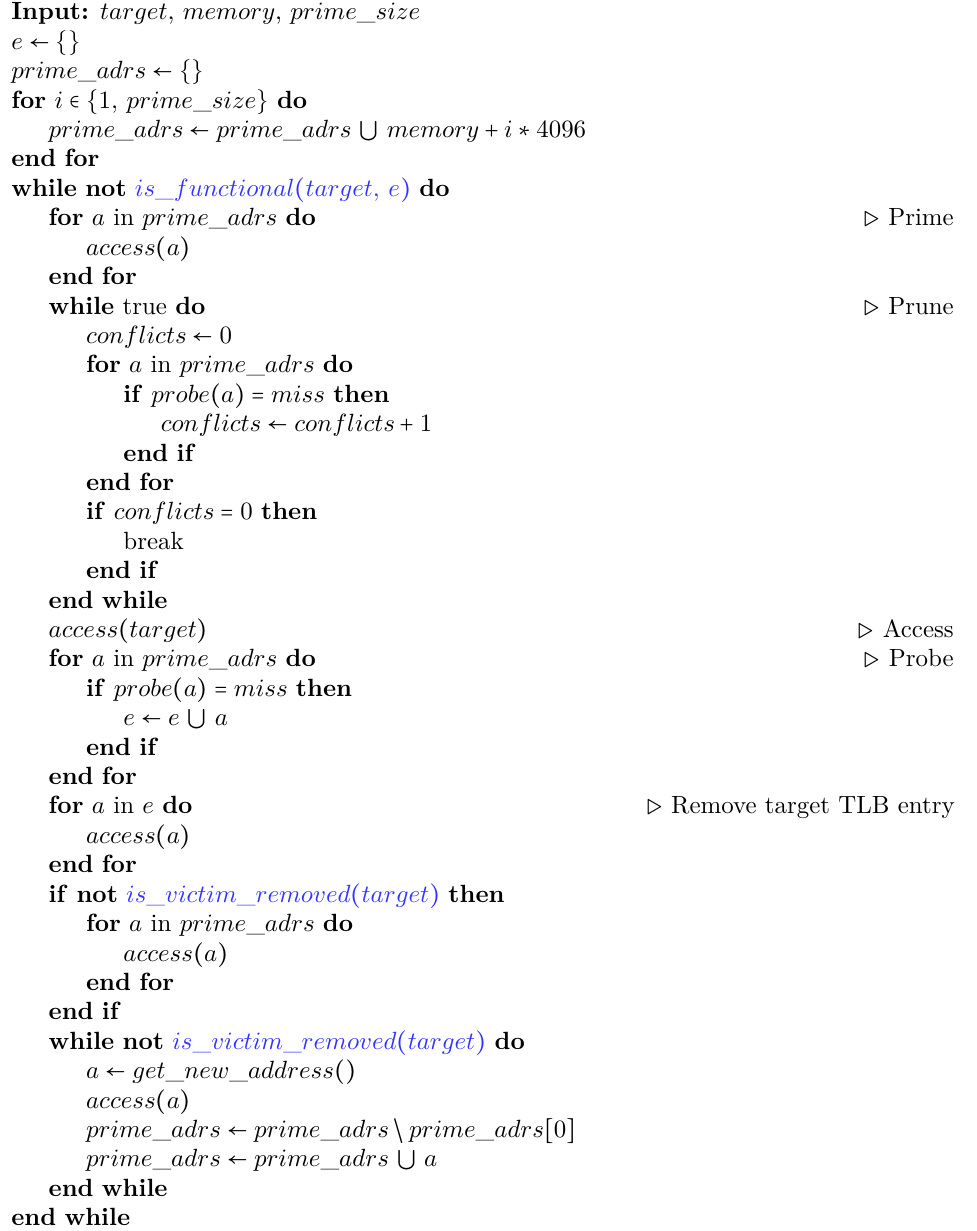
Algorithm 1 Prime+Prune+Probe attack on the TLB optimized for low number of TLB misses. Blue functions are not normally available to an